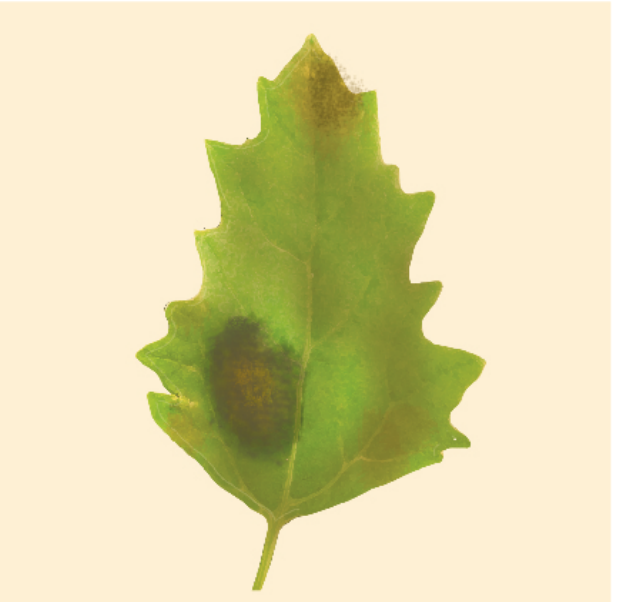
Figure 19. Symptoms of bacterial leaf spot on quinoa. Source: illustration adapted from Fonseca- Guerra et al.